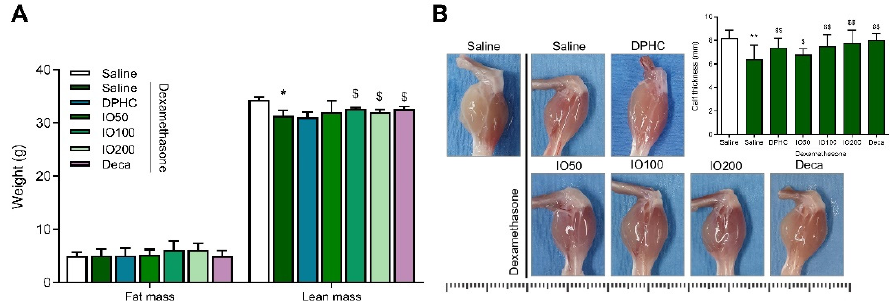
Figure 2. Fat mass and lean mass were determined on day 39 post-treatment ( A ). Representative calf muscle image and its thickness was assessed ( B ). All of the lines designating dimensions in ruler above each muscle indicate length in millimeters. The thickness was measured using a ruler and is expressed in millimeters. Each group was examined in n = 7 mice. All values are expressed as the mean ± standard error. Significant differences are indicated as * p < 0.05, ** p < 0.01 compared with control or $ p < 0.05, $$ p < 0.01 compared with DEX-saline (Mann–Whitney U test).